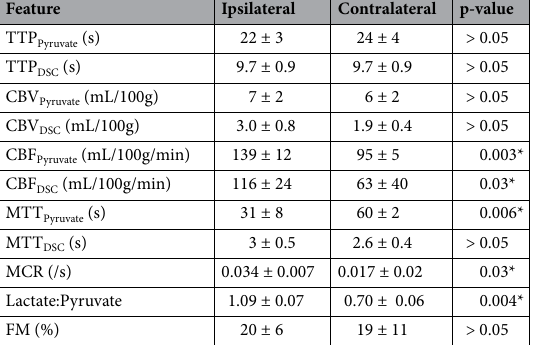
Table 2. Results from ROI analysis from the porcine model of stroke. * Statistically significant.